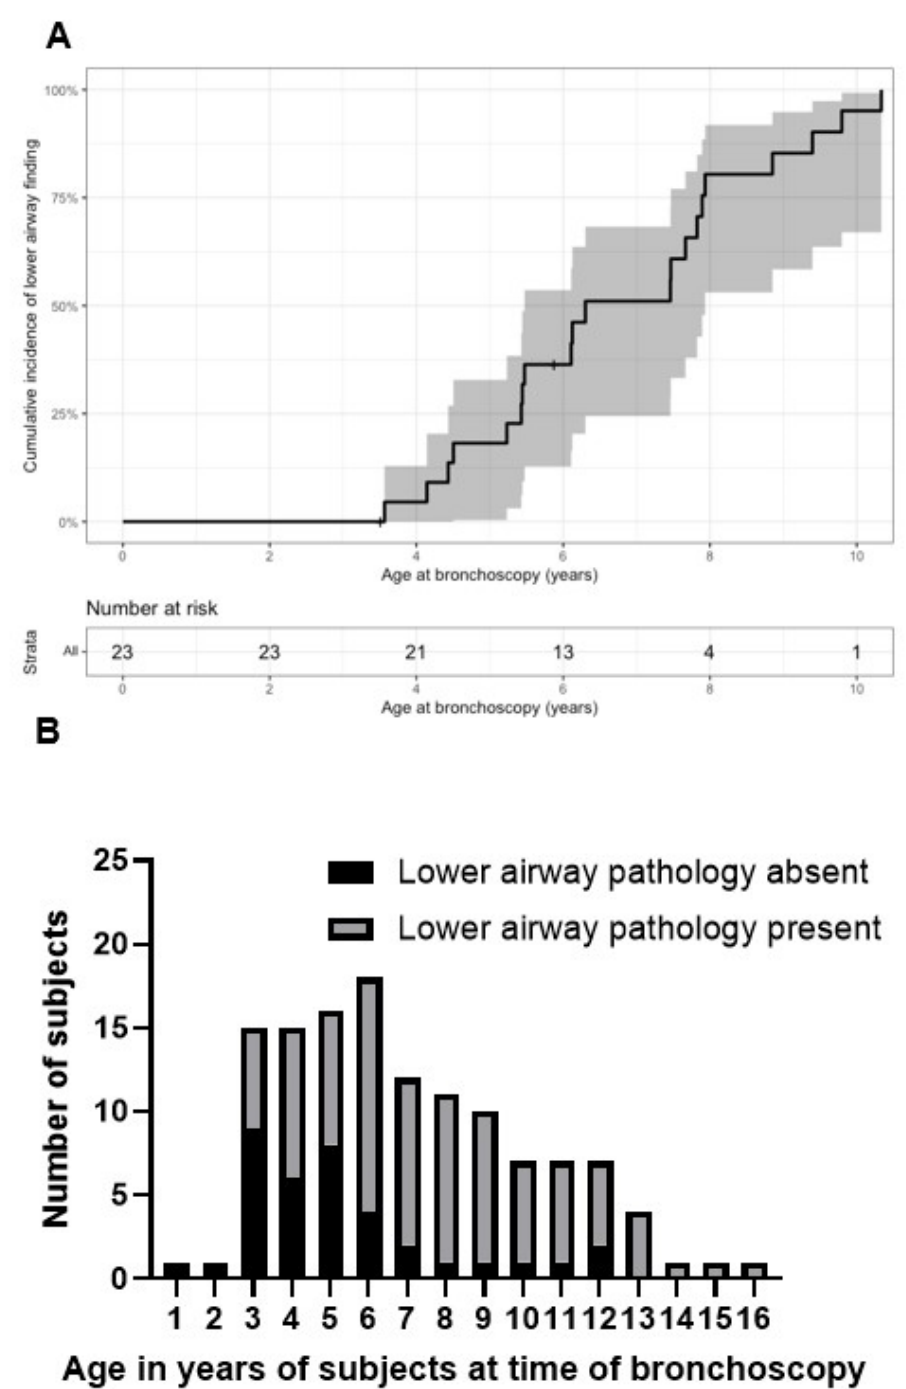
Figure 4. ( A ) Cumulative incidence of lower airway finding with 95% confidence interval. Each deflection point is the entire number of subjects who have bronchoscopies at that age, and the percentage of those subjects which have had bronchoscopies showing lower airway pathology. ( B ) Presence of lower airway findings over time. The dark bars represent bronchoscopies where lower airway pathology is absent, the light bars represent bronchoscopies where lower airway pathology is present. The total number of subjects on the y axis is the number of subjects who underwent bronchoscopy per year of age. Each individual was accounted for only once per year.